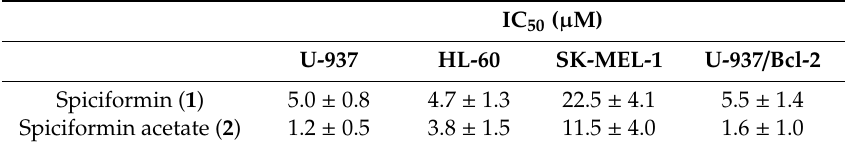
Table 1. E ff ects of sesquiterpene lactones on cell viability of human tumor cell